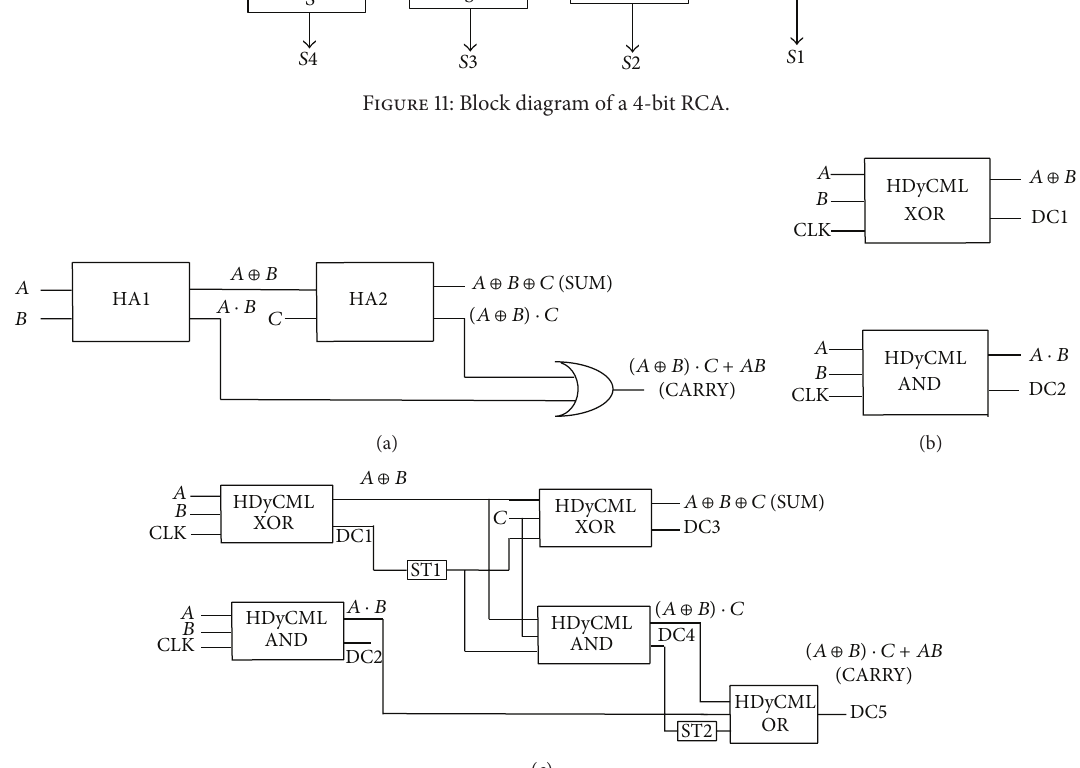
Figure 12: (a) Full adder schematic; (b) H-DyCML half adder schematic; (c) complete schematic of D-HyCML full